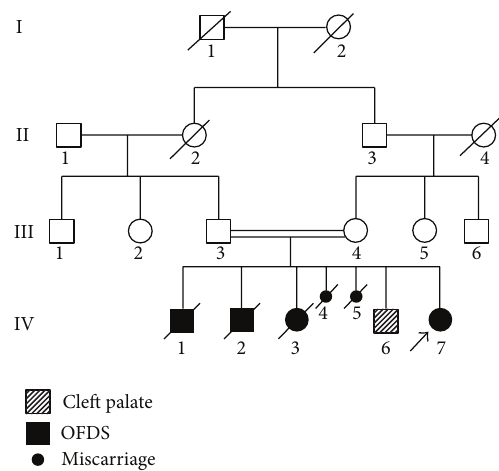
Figure 1: Pedigree of the family (IV-7: proband-with arrow, IV-1, 2, 3: ex siblings with the same phenotype, IV-4, 5: miscarriage, and IV- 6: healthy sibling with cleft palate).